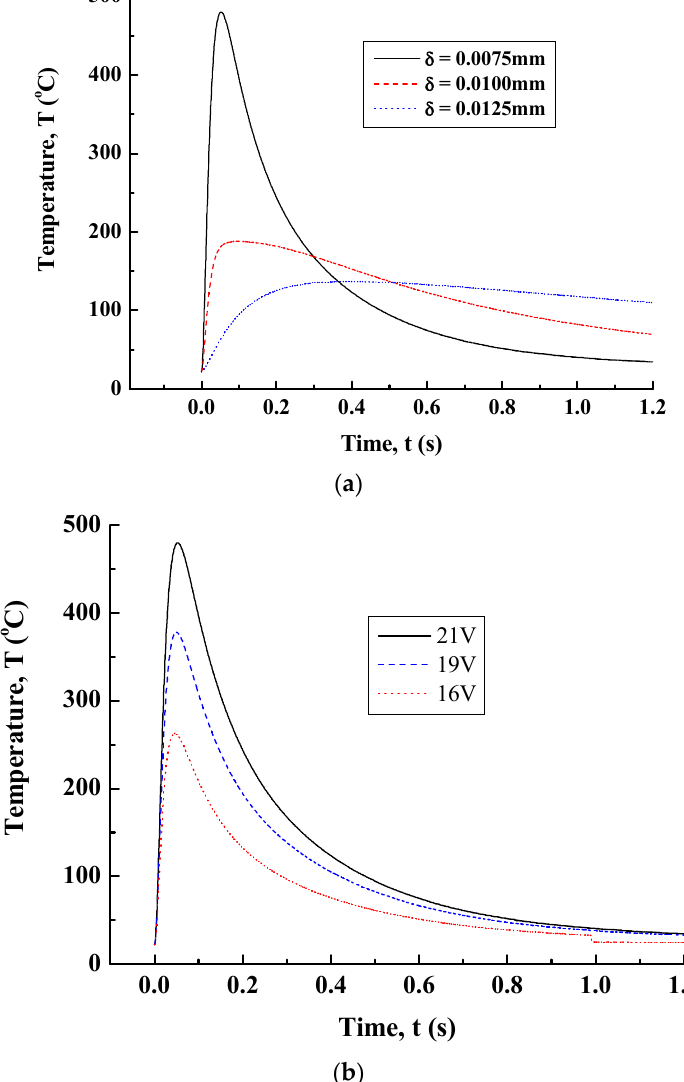
Figure 3. Temperature variation of nickel sheet with C = 68,000 µF [31]. ( a ) Thickness effect with 21 V, ( b ) Voltage effect with δ = 0.0075 mm.